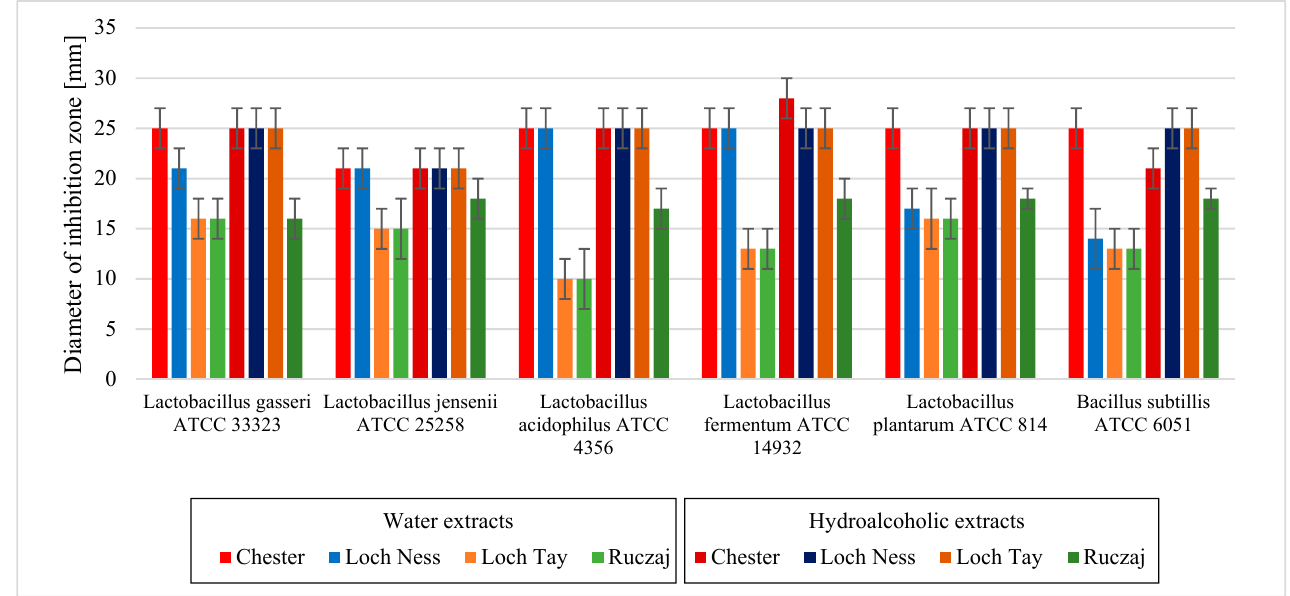
Figure 3. Microbiological activity of blackberry leaves extracts in their initial concentrations on health-promoting bacteria. Error bars define the SD values.